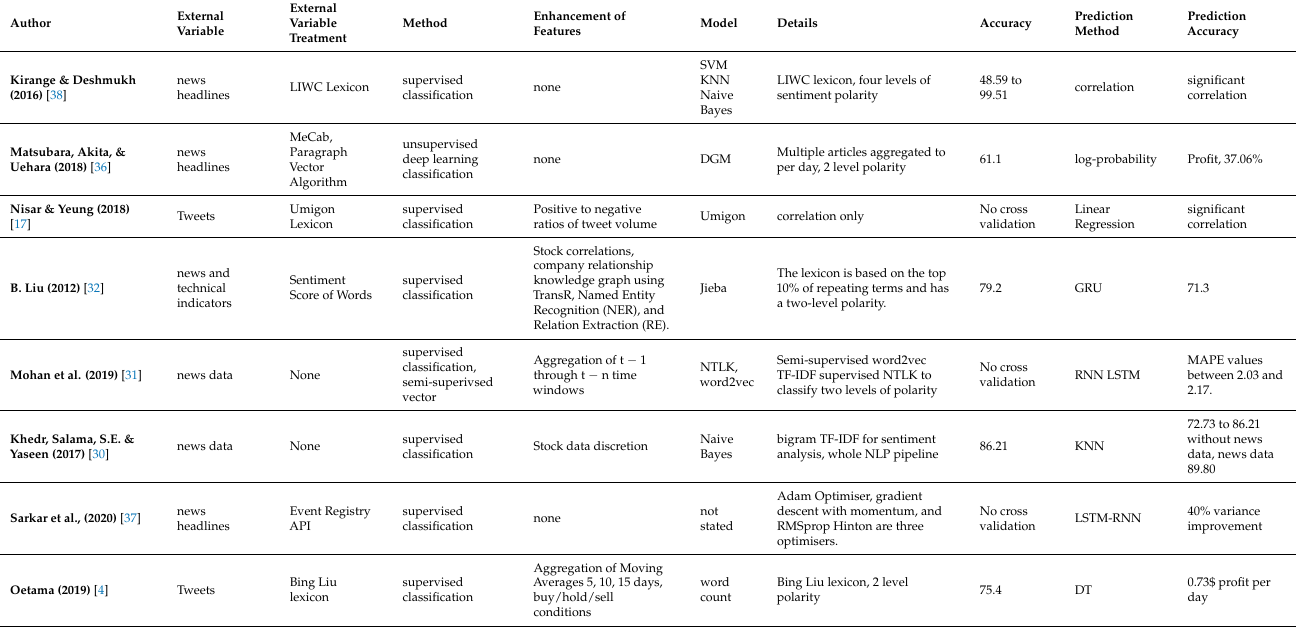
Table 1. Comparative Analysis of Various Stock Prediction Methods Based on Sentiment